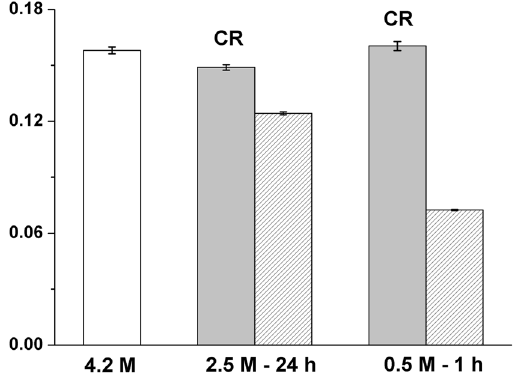
Figure 7. Mean effective force constant < k’ > of Hbt. salinarum . The reactivated samples (CR, solid grey blocks) are compared to the corresponding value under stress (dashed patterns) and the control (white column). Errors bars represent standard